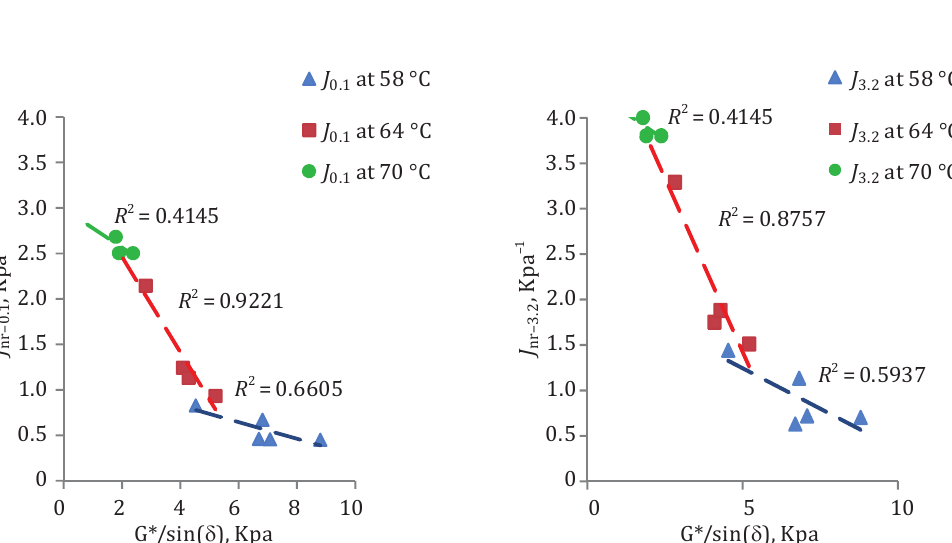
Figure 18. Effect of modifier content and temperature on results